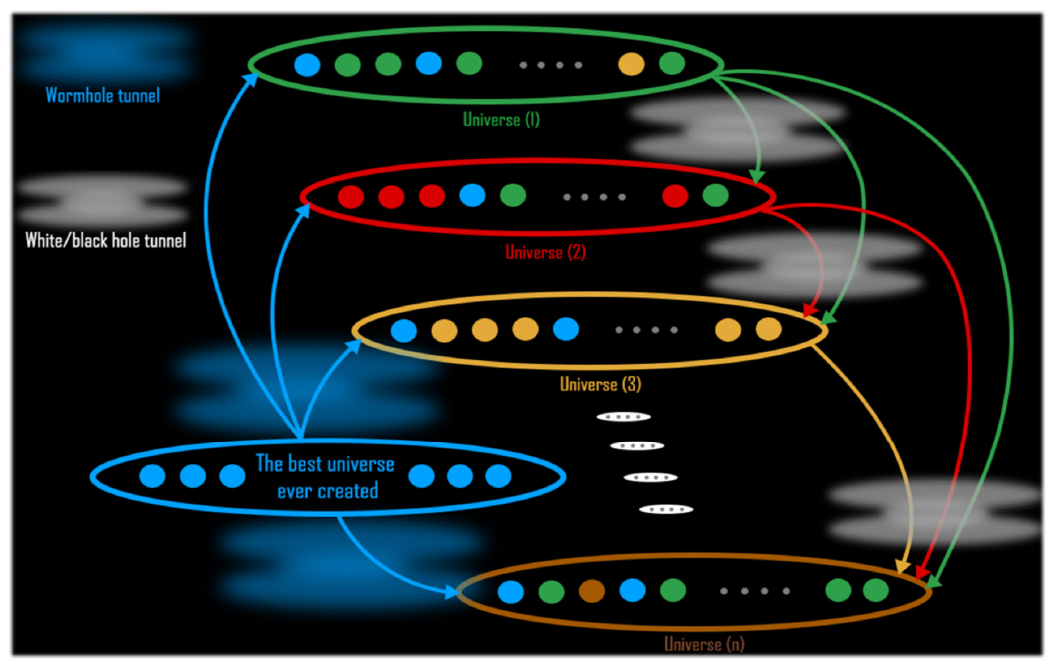
Fig. 2. Conceptional Model of MVO